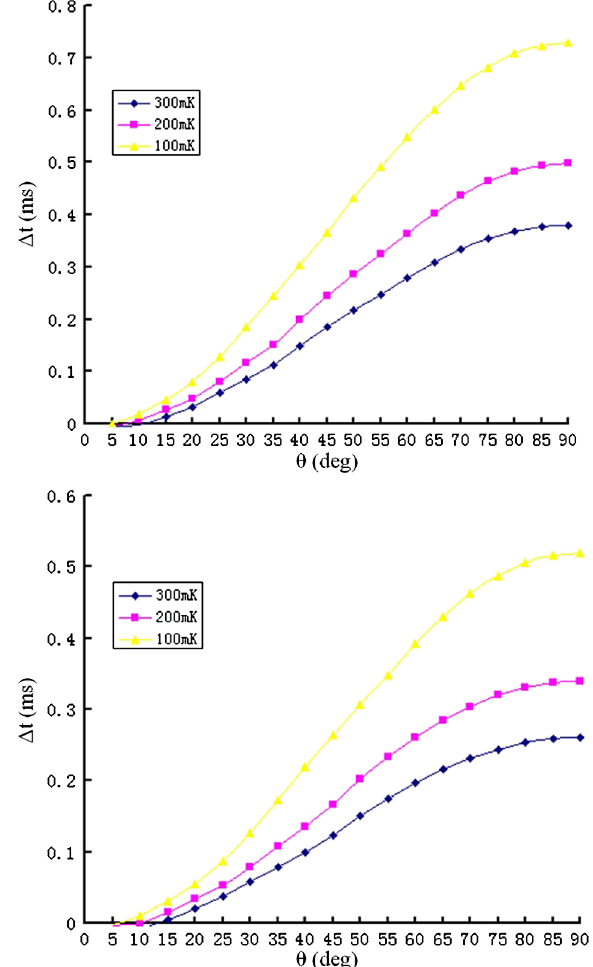
FIG. 13. Time error calculated for 50 cm away detection at different angles and system resolutions. (cid:4) is defined as in Fig. 3. Top: Second sound velocity at 2 K is adopted. Bottom: Second sound velocity at 1.8 K is